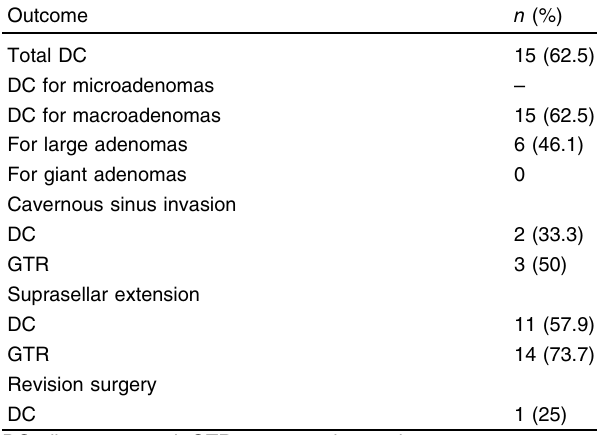
Table 3 Surgical outcome for nonfunctioning pituitary adenomas